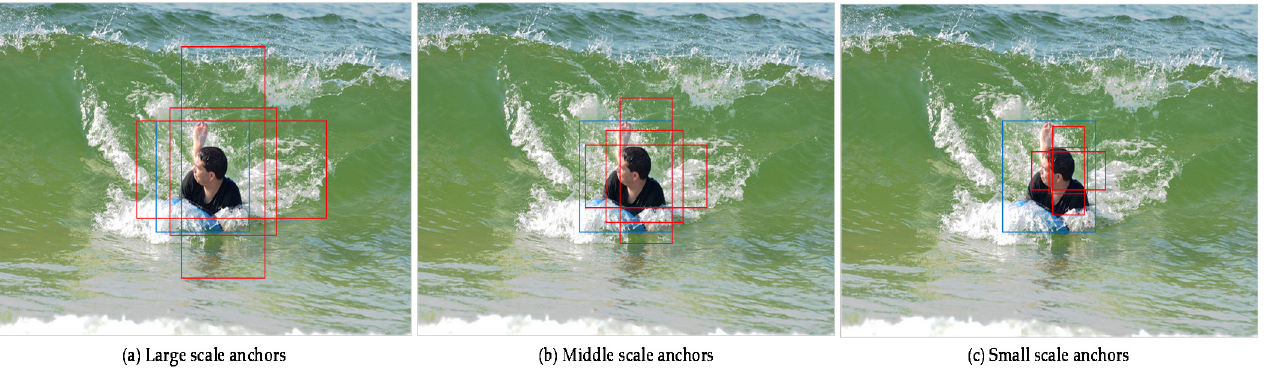
Figure 1. This is the schematic diagram of a set of pre-defined anchor boxes. There are nine anchors with different scales and aspect ratios. The red box represents the anchors and the blue box represents the ground-truth box.